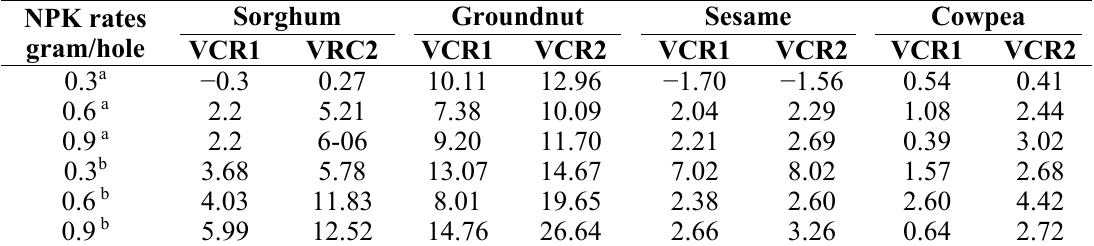
Table 12. Value cost ratio (VCR) of NPK fertilizer micro-dose rates with and without seed priming (VCR1-grain yield, VCR2-grain + hay yield). a = non-primed seed, b = primed seeds.